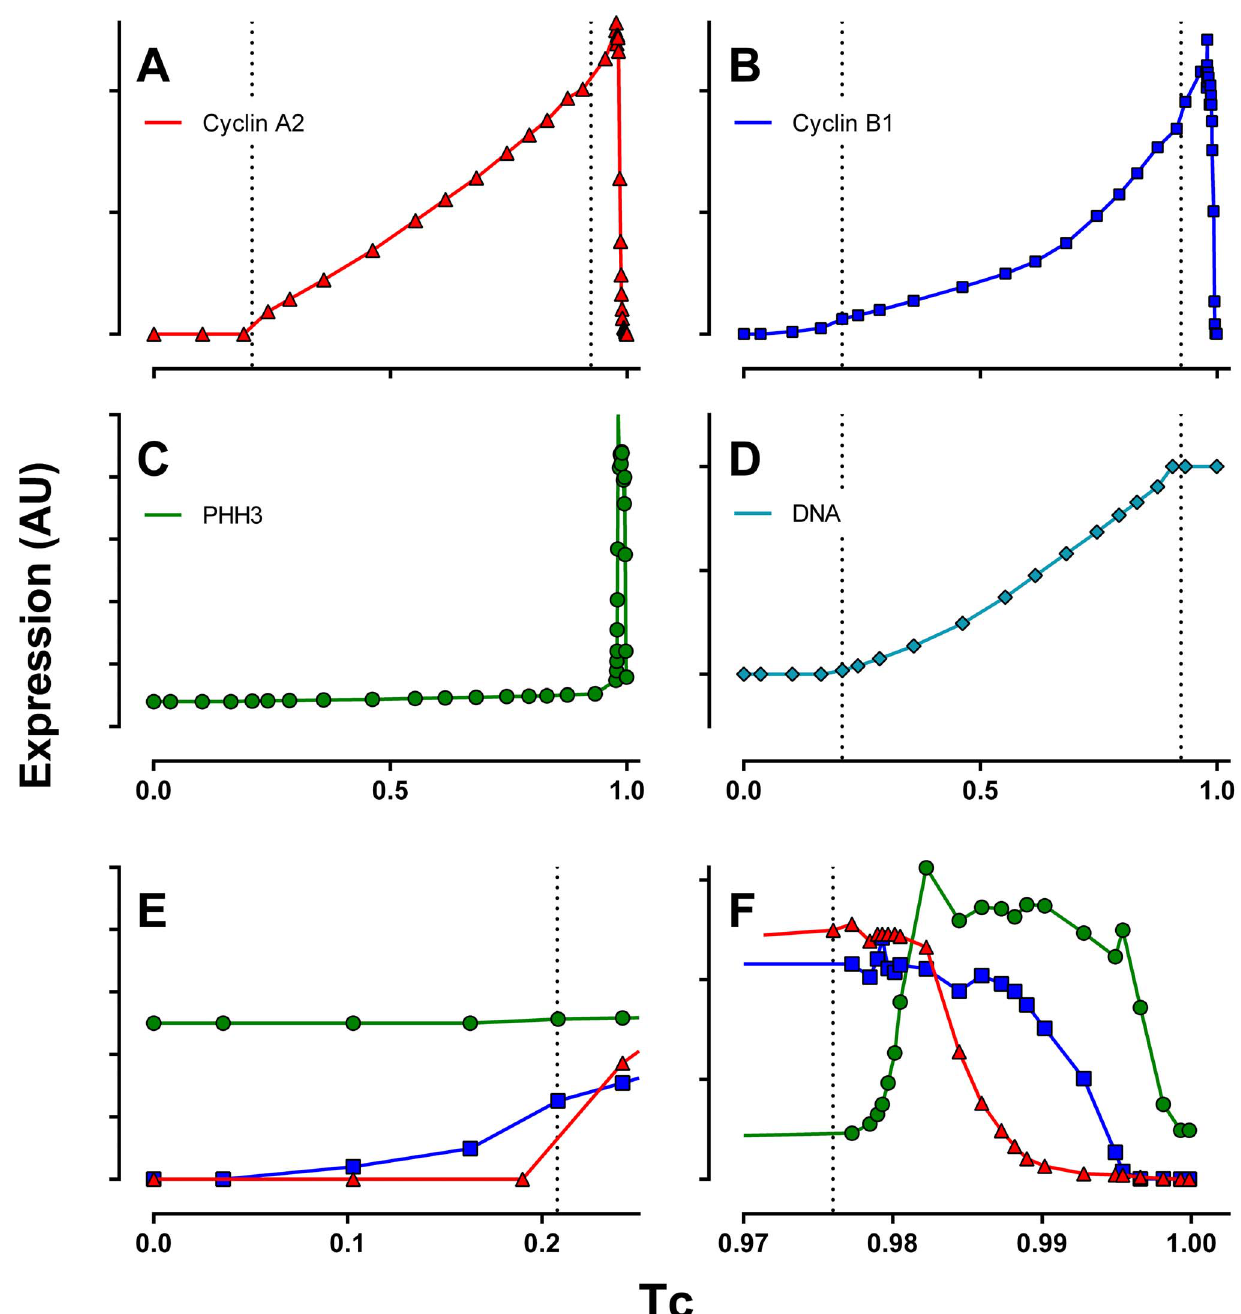
Figure 1. Cell cycle expression. Normalized expression profiles of cyclin A2 ( A ), cyclin B1 ( B ), and PHH3 ( C ), and DNA content ( D ). A magnified view of the first 25% of the cell cycle is presented in E , and the final 3% of the cell cycle in F . K562 cells were stained, measured by flow cytometry, and sample data were analyzed to produce expression profiles as described in Materials and Methods. Dotted lines demark the G1/S, S/G2, and G2/M boundaries as determined by cell cycle analysis of DNA content and gated enumeration of PHH3 positive mitotic cells.